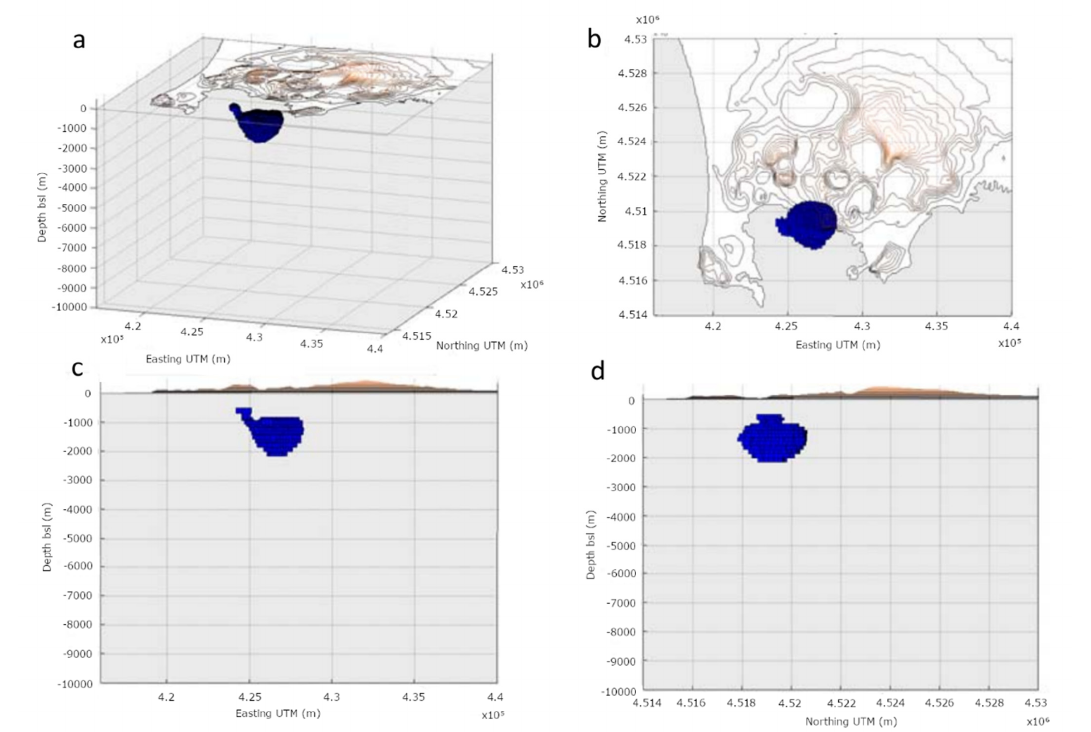
Figure 6. Source location, depth and shape for deflation period of 1993–1999. ( a ) 3D perspective; ( b ) map view of source below Campi Flegrei caldera; ( c ) EW vertical profile; ( d ) NS vertical profile